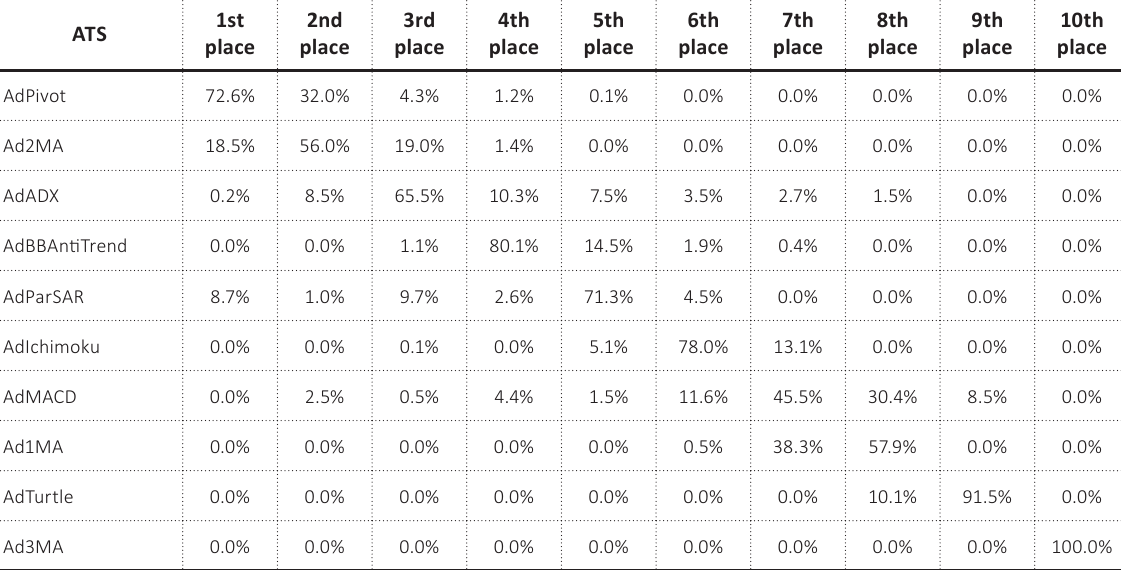
Table 3. Classification occurrences for all systems based on the WM values for 6-month constant BT